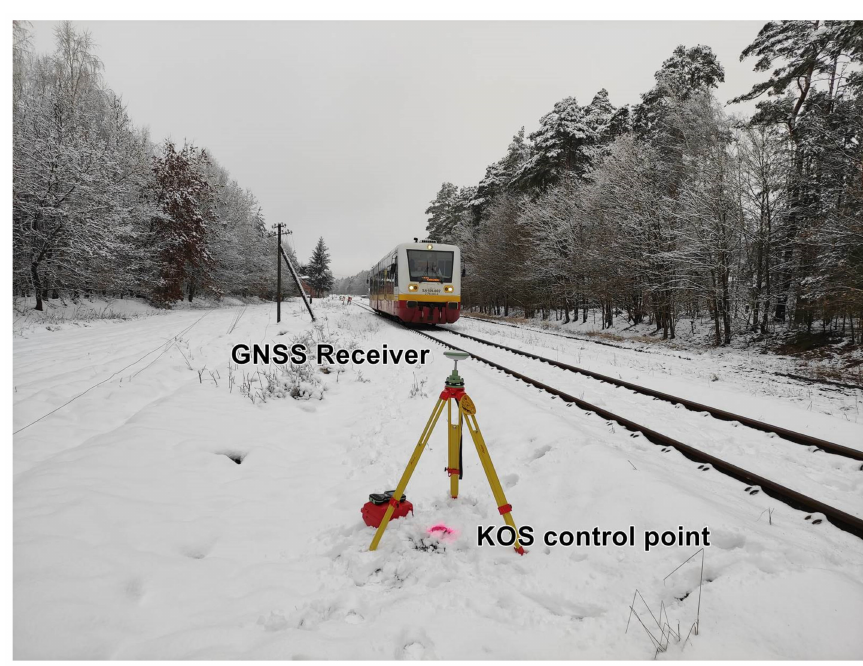
Figure 8. GNSS receiver during the measurement of KOS